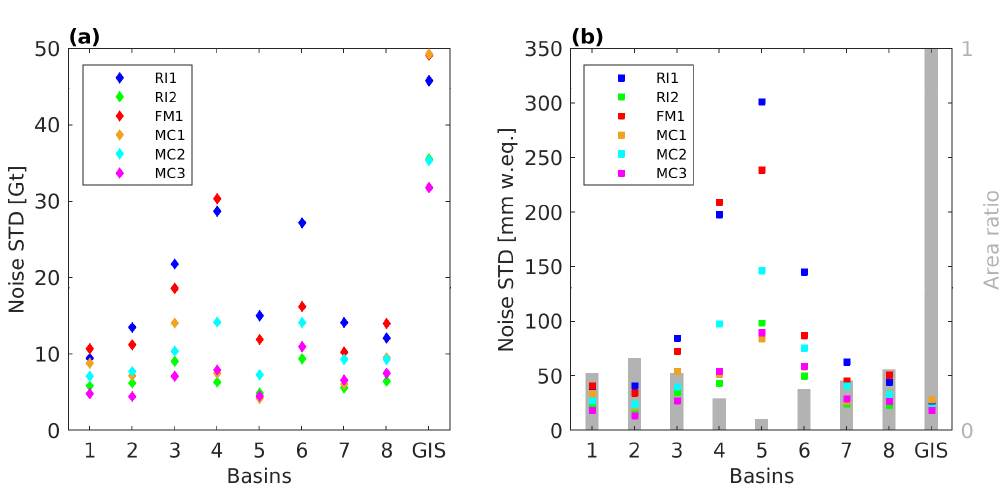
Figure 11. Noise level, given in terms of the scaled standard deviation of the noise time series, for all GIS basins and the entire GIS, derived from ( a ) the mass change time series and ( b ) the time series of the average surface density change. Grey bars indicate the ratio between the basin areas and the entire GIS